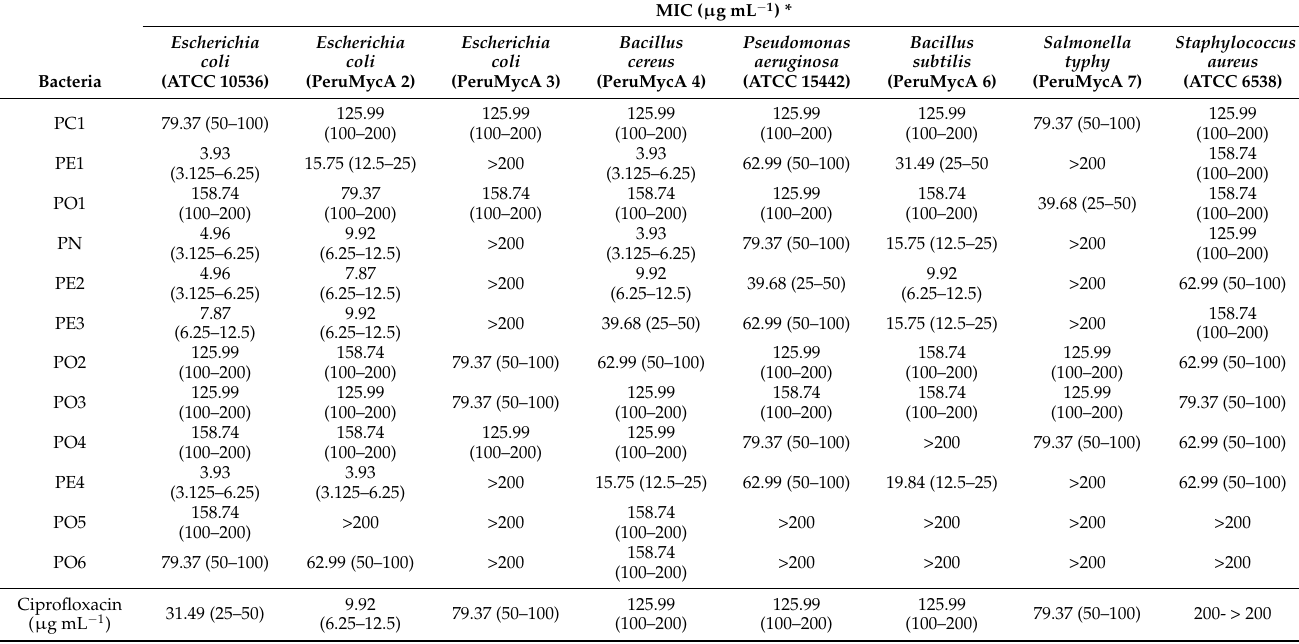
Table 7. Minimal inhibitory concentrations (MICs) of Pleurotus mycelia (S2) extracts against bacte- ria